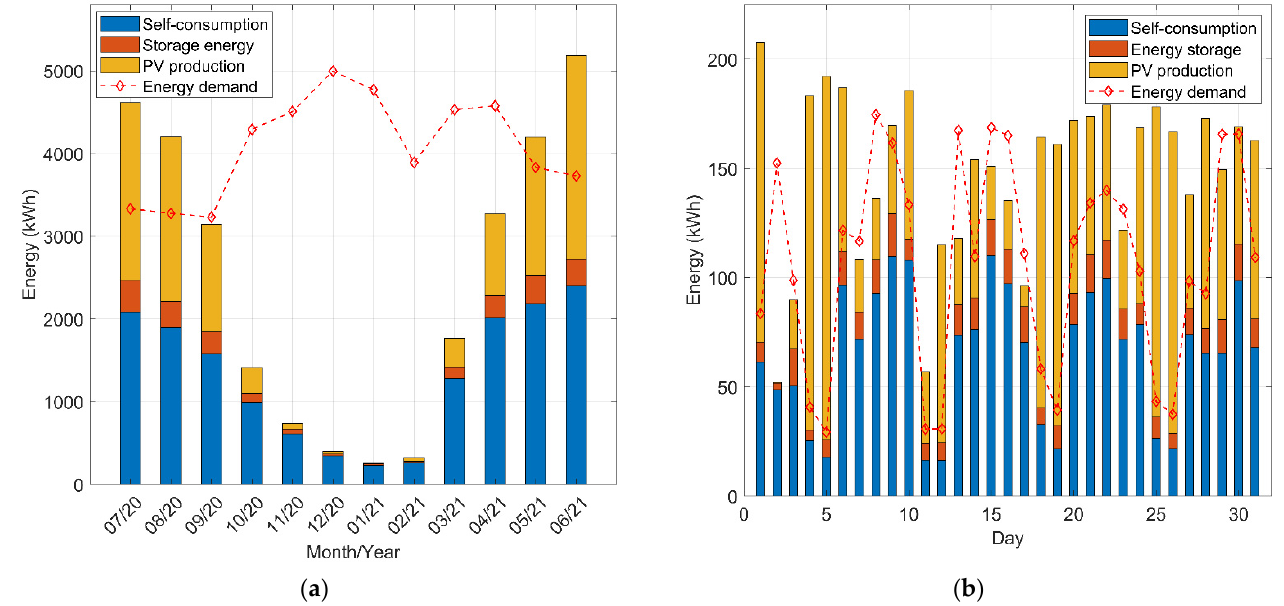
Figure 10. Energy balance profiles including self-consumption and consumption from the battery ( a ) for a year of operation ( b ) in July 2020 (summer month).